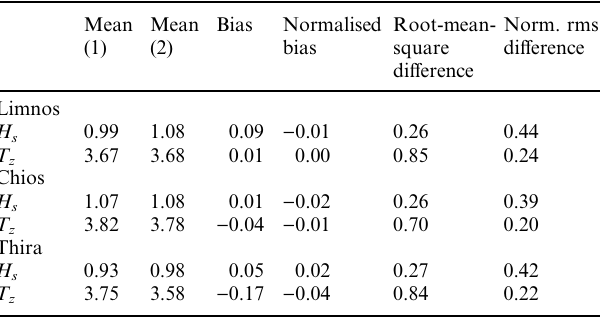
Table 15. Statistics for the storm December 1991, ) 128 points. Comparison of results from WAM-cy3 and AUT model using UKMO LAM new wind